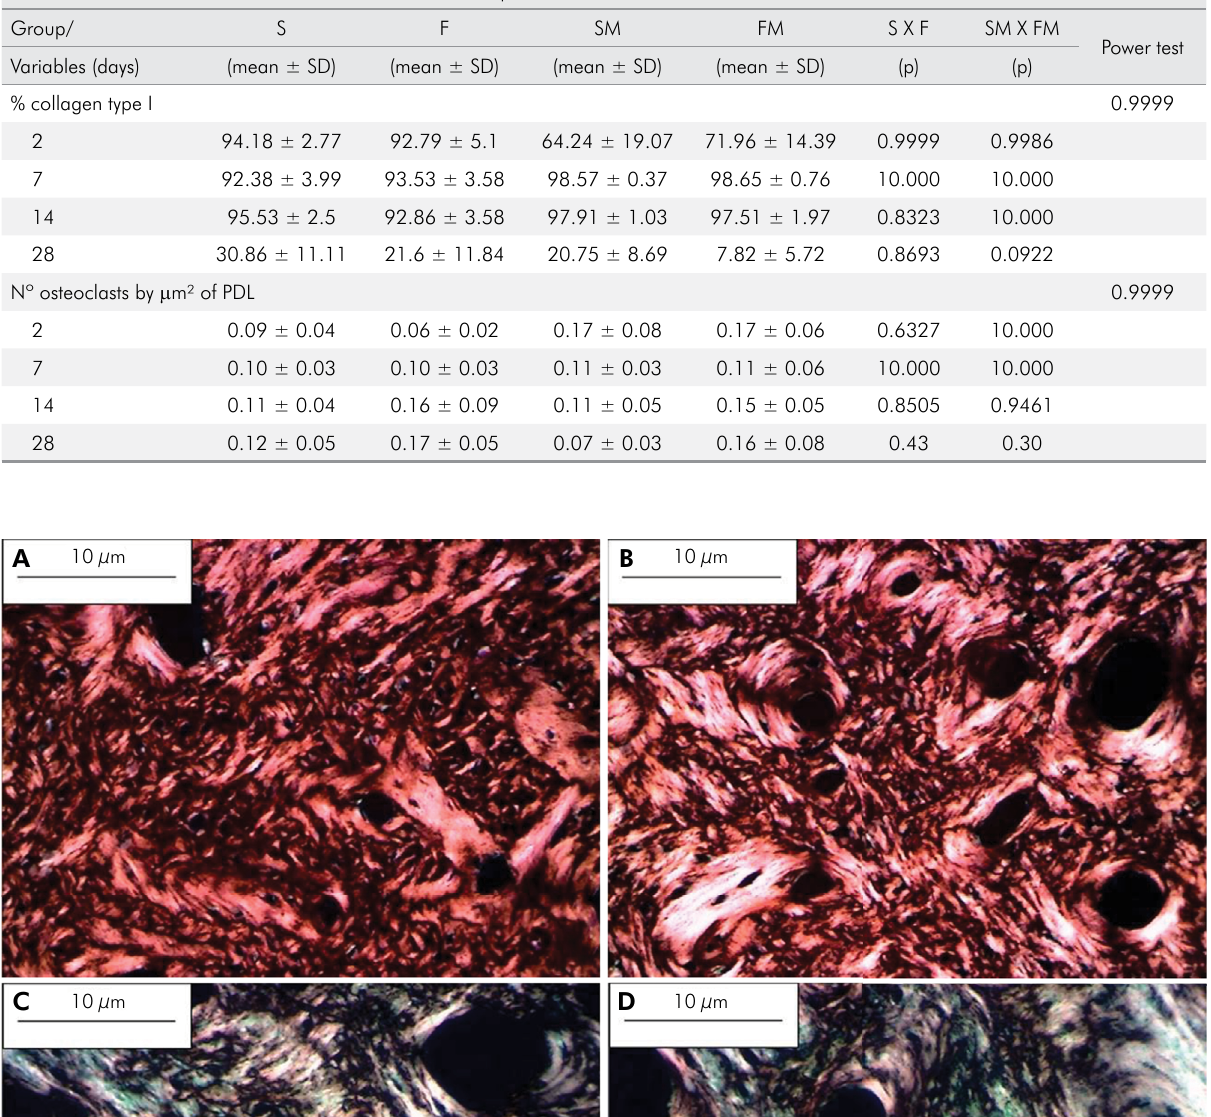
Table 2. Means and standard deviations of number of osteoclasts/ μ m² and percentage of type I collagen in the saline (S), fluoxetine (F), saline with tooth movement (SM), and fluoxetine with tooth movement (FM) groups. Comparisons - Games-Howell Test